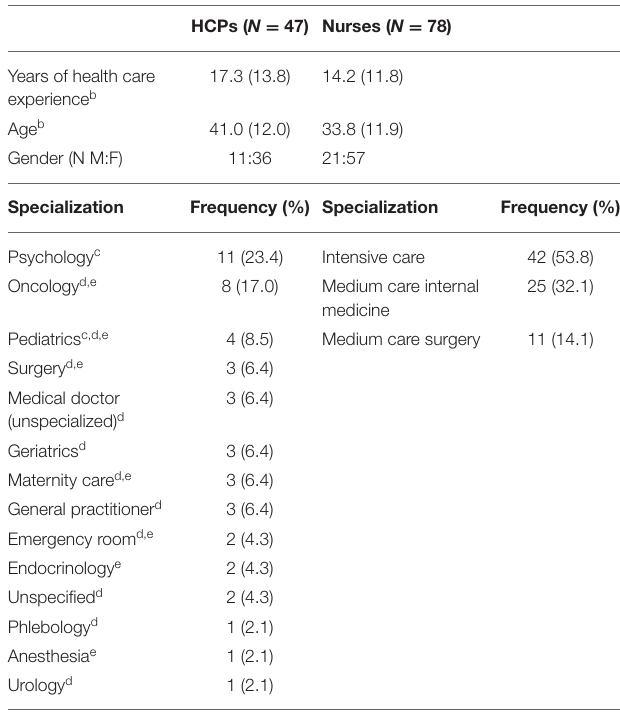
TABLE 1 | Sample characteristics a